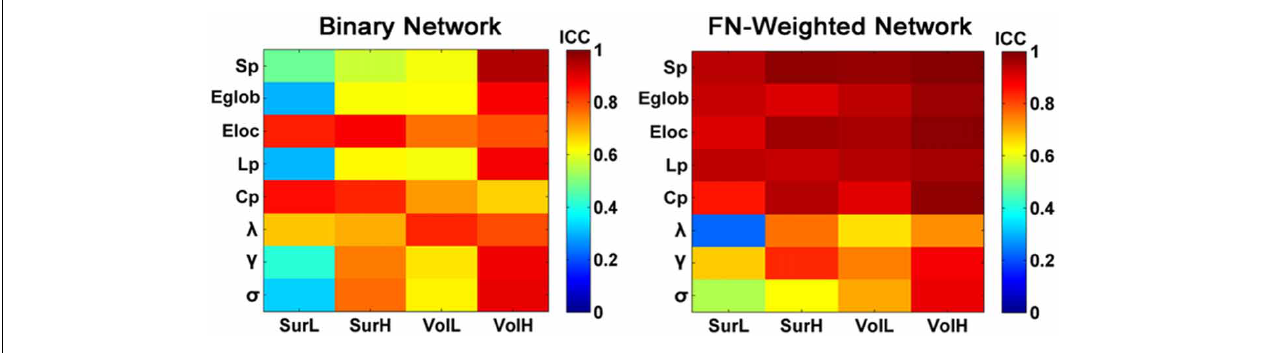
FIGURE 11 | The TRT reliability of global network metrics of binary and weighted structural networks. The ICC values of global network metrics from low to high were presented with